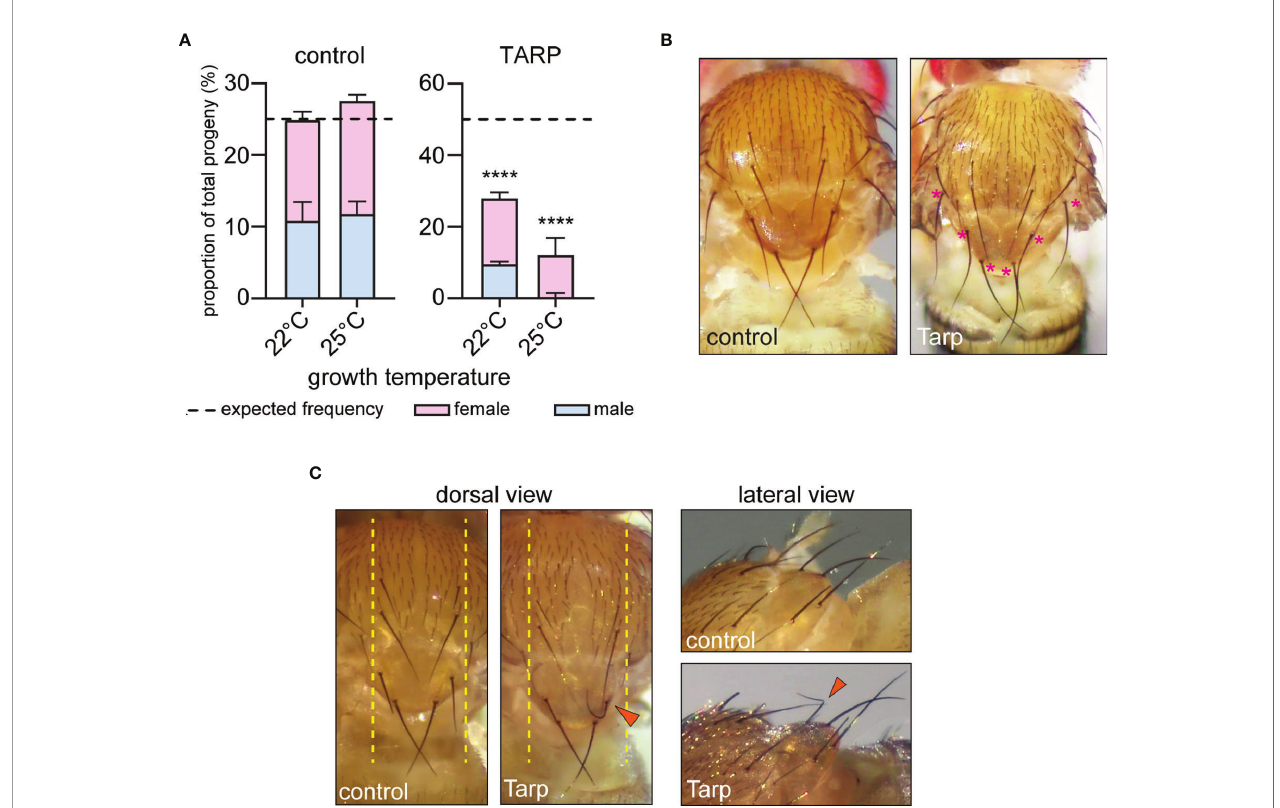
FIGURE 2 | Tarp induces abnormal curvature of large mechanosensory bristles. (A) The proportion of ubiquitously expressing GFP (control) or Tarp fl ies within the progeny population was recorded. The impact of Tarp expression on fl y viability was assessed by comparing the observed proportion to expected Mendelian ratio (dashed lines). Fischer ’ s exact test was used to test for signi fi cance between observed and expected values (****p<0.0001). The male-to-female ratio is indicated by blue and pink bars, respectively. (B) Dorsal thorax of adult fl ies ubiquitously expressing GFP (control) or Tarp, displaying small and large mechanosensory bristles. In Tarp-expressing fl ies, asterisks (pink) mark large mechanosensory bristles that display abnormally increased curvature. (C) Dorsal thorax of fl ies that express GFP (control) or Tarp in the central region of the thorax (yellow dashed lines) via pnr-GAL4. An abnormally curved bristle (arrowhead) is observed in Tarp-expressing fl ies. The same fl ies were imaged in dorsal and lateral